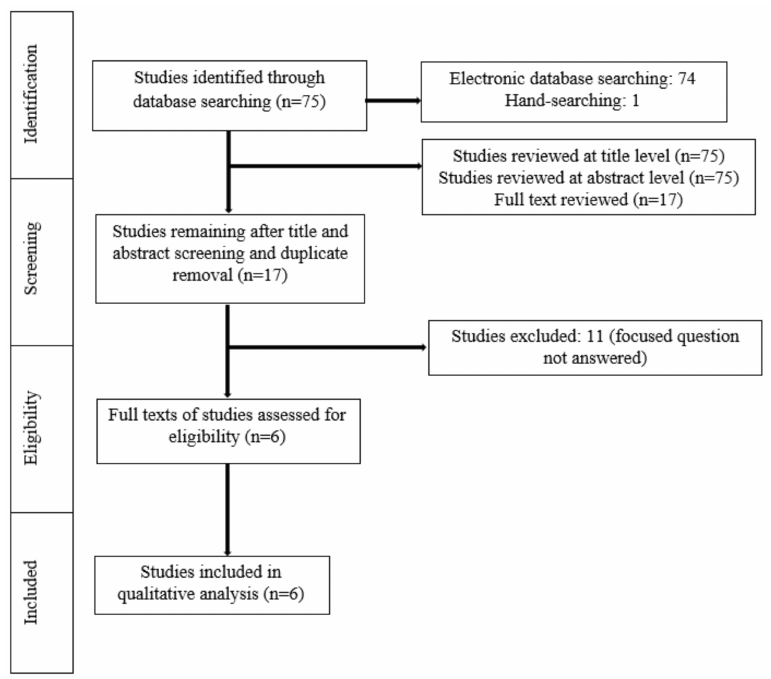
Figure 1. Study selection according to PRISMA